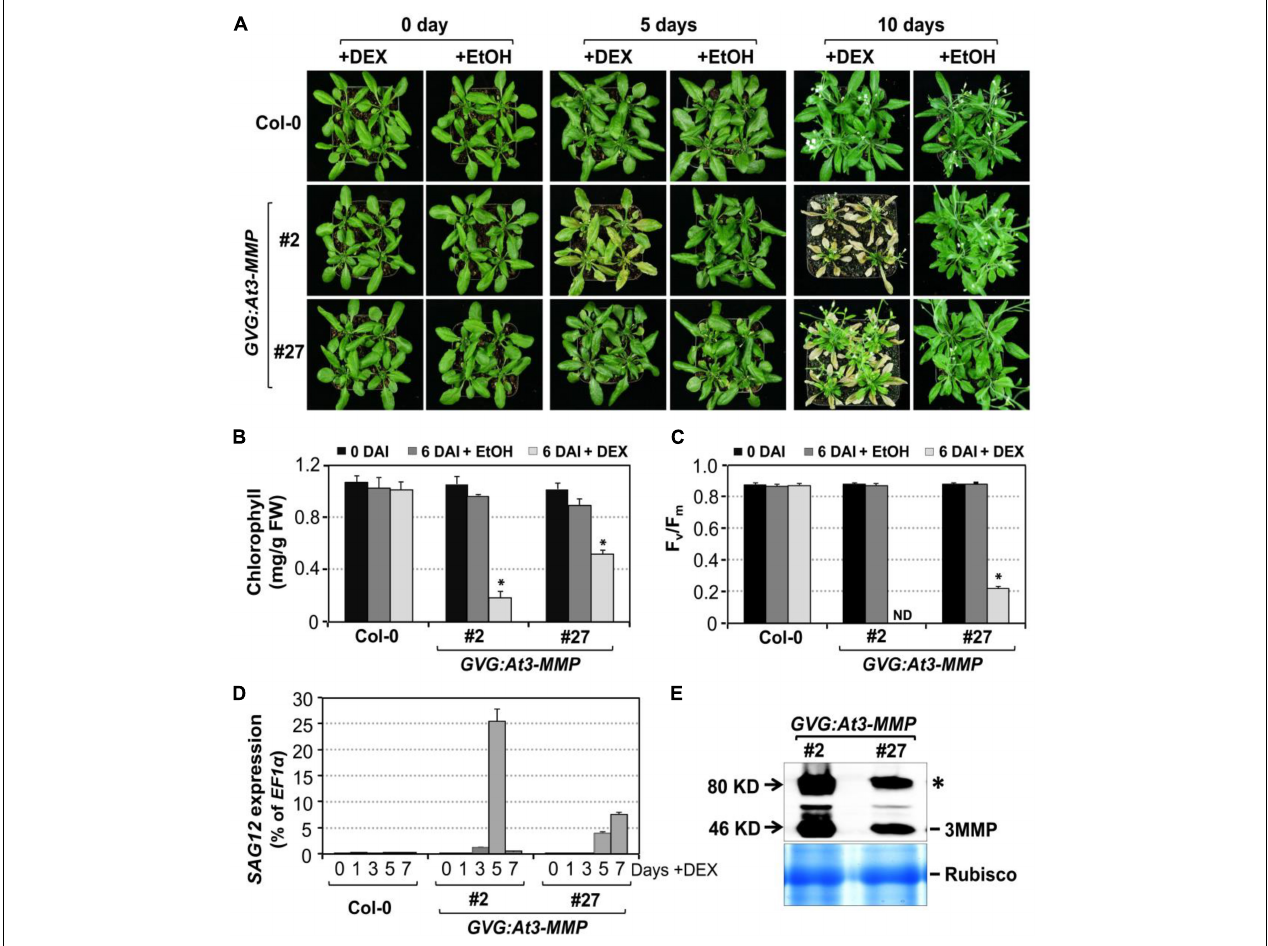
FIGURE 7 | Conditional expression of At-3MMP is sufficient to induce leaf senescence. (A) The senescence phenotype of inducible At3-MMP transgenic lines (#2 and #27) and wild type plants after treatment with 30 µ M DEX or EtOH (solvent control) for 0, 5, and 10 days. 4-week-old soil-grown plants were sprayed with DEX or EtOH. Photos were taken at the indicated time points. (B,C) Chlorophyll content (B) and F v /F m (C) of fifth to seventh leaves in wild-type and transgenic plants before and after DEX or EtOH treatment. Values are means ± SD, n = 10. ND: no detected. (D) RT-qPCR analysis of SAG12 transcript levels at indicated times after DEX treatment. Values are means ± SD, n = 3. (E) Induction of At3-MMP protein at 24 h after DEX (5 µ M) treatment. HA-tagged At3-MMP protein was detected by immunoblot analysis using anti-HA antibody (upper). Coomassie brilliant blue staining of a duplicated gel was used to confirm equal loading (bottom). Asterisks indicate a significant difference (P ≤